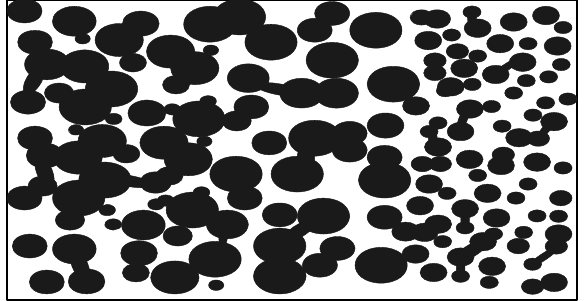
Figure 5. Schematic illustration showing the graded porous structure prepared by the powder metallurgy